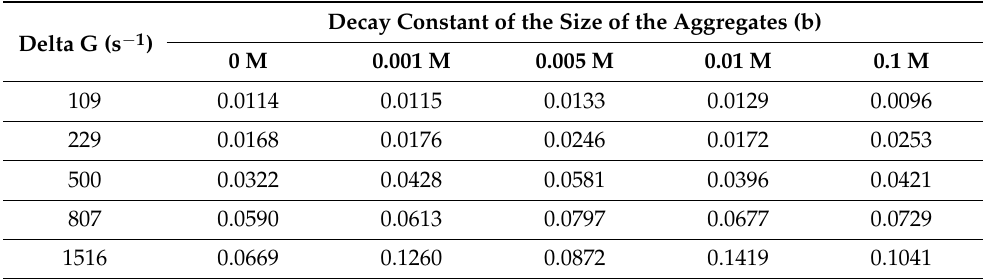
Table 3. Decay constants of the size of the aggregates (b) at different salinities and shear rate increases. Decay Constant of the Size of the Aggregates Delta G (s − 1 )